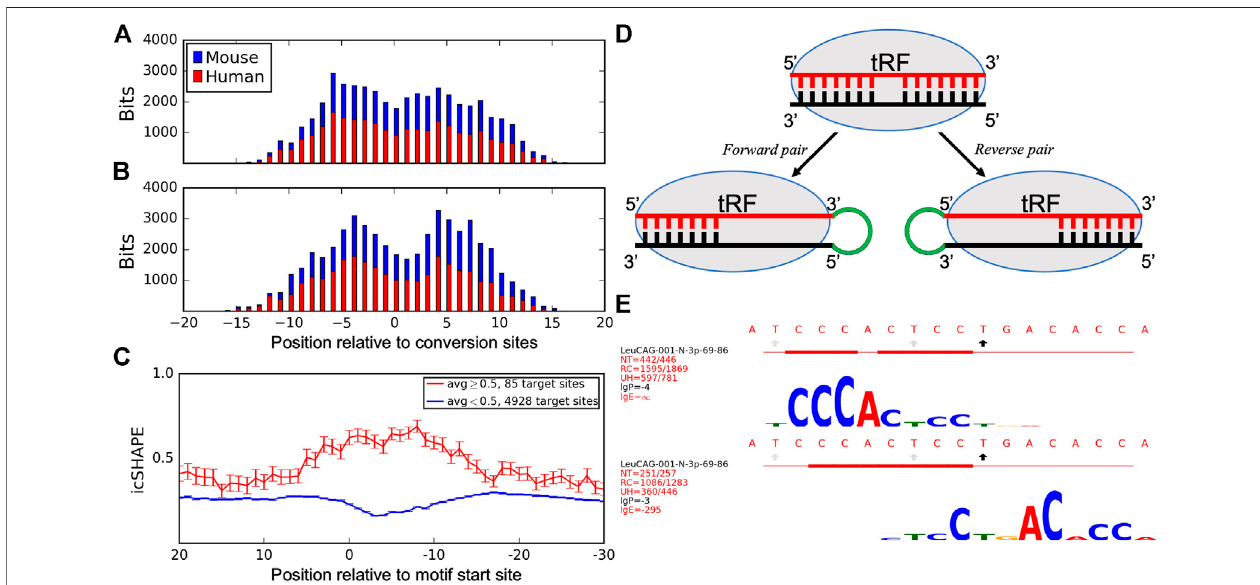
FIGURE 3 | Analyses of Ago-crosslinking and target binding sites. Histograms show the cumulative bitscores of motifs in (A) forward and (B) reverse pairs relative to the most frequent T → C conversion sites identi fi ed for all motif-containing tRFs in human cells (blue) and identical tRFs in mouse cells (red). Bitscores (heights of logo symbols,re fl ectingthecomplementarymatchfrequenciesbetweentRFsandtargetnucleotides)foreverypositioninthemotifwereaddedupinrespectivepositionsofall motif-containing tRFs relative to their conversion sites as a measure of target binding frequencies in these positions. tRFs are aligned to the most frequent conversionsites and shown from5 ′ to3 ′ . (C) icSHAPE scoresoftarget sites relative tothepredictedinteractingmotifs. Activity scoresareaveraged foreverynucleotide ofall uniquemRNA targets and separated intosingle-stranded (red) anddouble-stranded (blue)regions formed at themotif site. mRNAtargets are alignedtothestartof motif-binding sites and shown from 3 ′ to5 ’ . (D) Amodel describing how Ago-crosslinking and target binding results may be connected to the observed asymmetries of tRFandtargetpairsandtheirmotifs. (E) MotifsfoundforCysGCAtRFintheforward (top) andreverse (bottom) chimeras,seethelegendof SupplementaryFigureS5 for